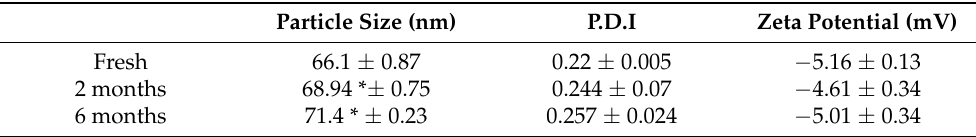
Table 2. The effects of storage of the selected ASP-loaded LNCs (F22-AS) on particle size, PDI and zeta potential.